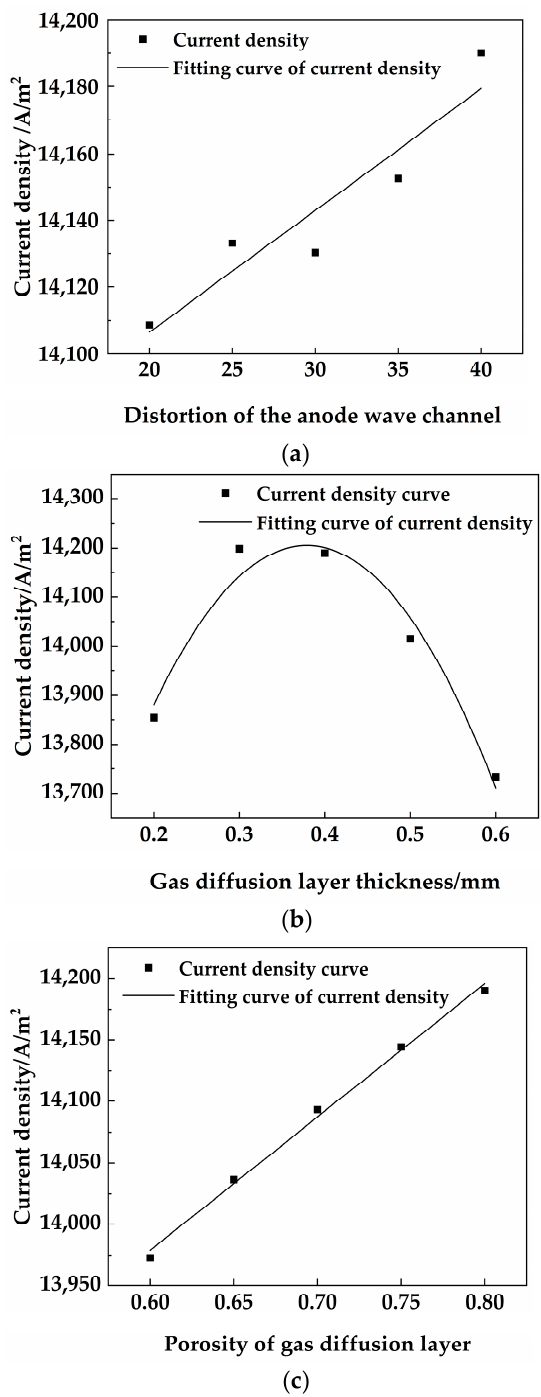
Figure 7. The influence of factors’ different levels on the current density. ( a ) The influence of different anode wave channel distortion on current density; ( b ) the influence of different gas diffusion layer thickness on current density; ( c ) the influence of different porosity on current density.